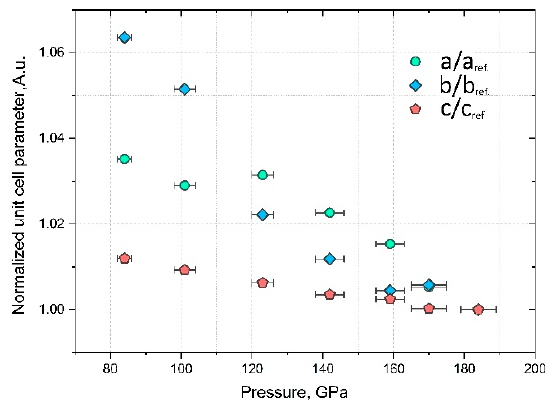
Figure 5. The pressure dependence of the normalized unit cell parameters of Ni 3 C at 300 K.